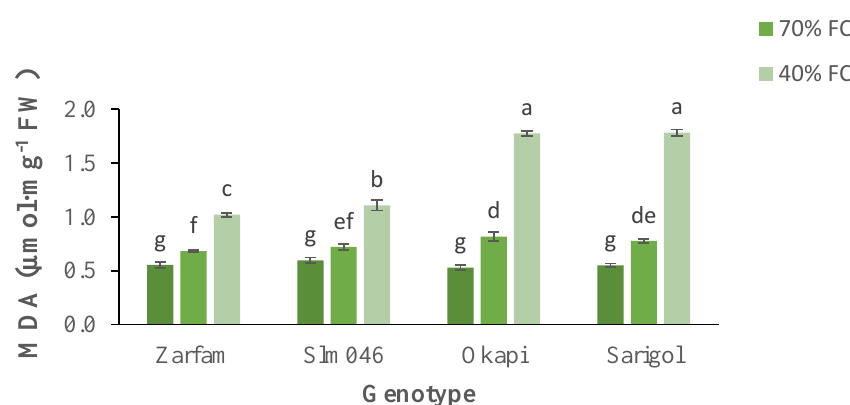
Figure 5. Interaction effect of drought stress and genotype on the malondialdehyde (MDA) content of canola leaves. Data are means ( n = 3) ± SE. Different letters indicate differences ( p < 0.05) among treatments according to the Duncan test.